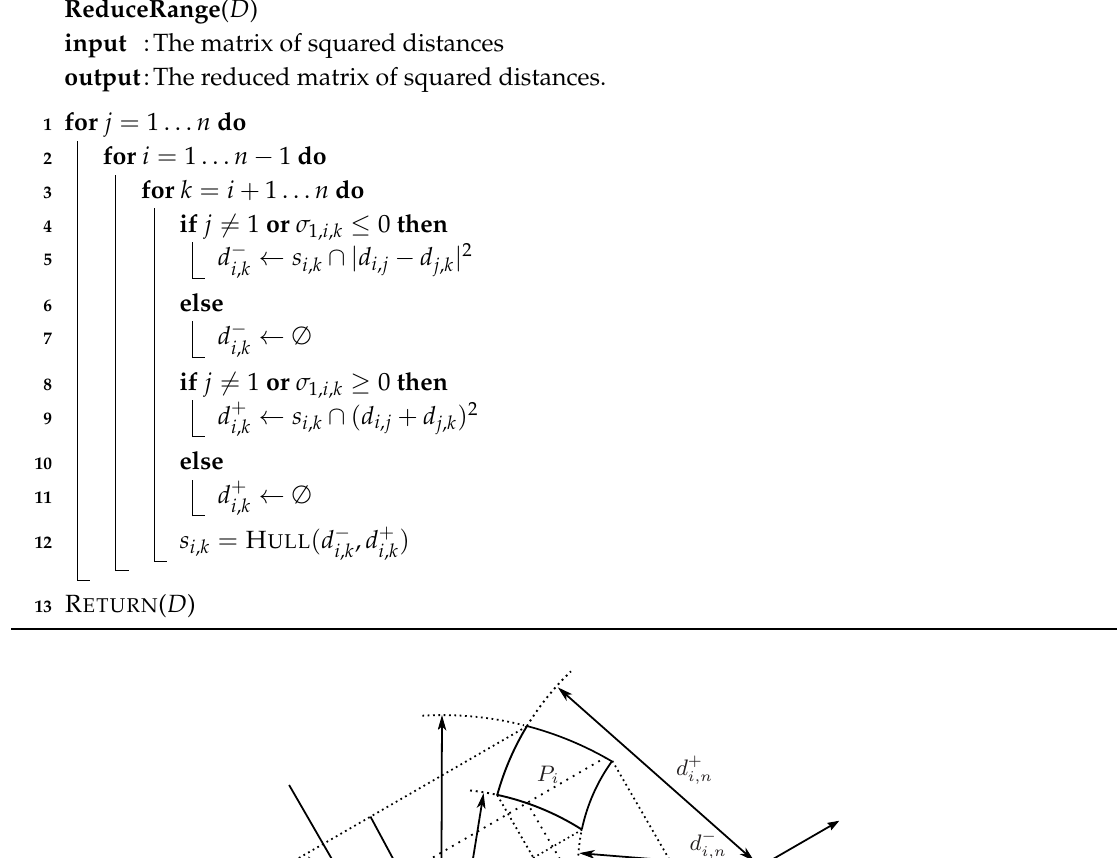
Algorithm 1: Range reduction using distance and orientation constraints. ReduceRange ( D )